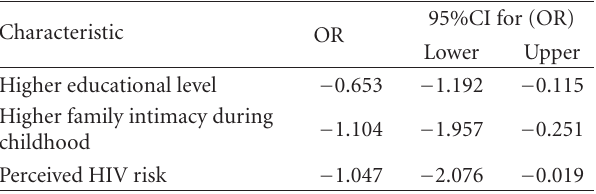
Table 3: Predictors of unprotected sex with injecting drug users among Iranian female sex workers ( n =